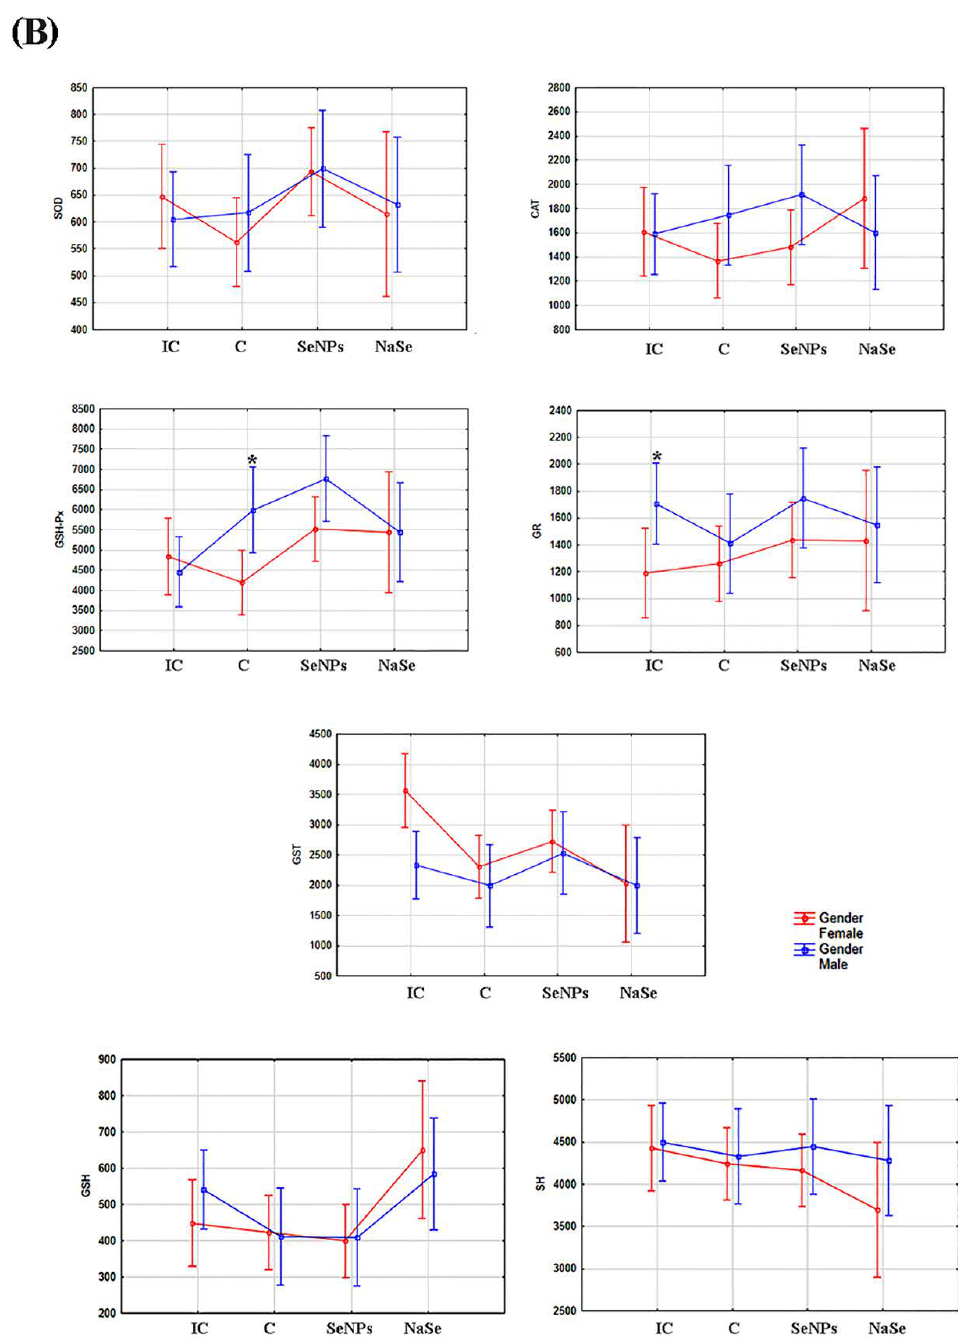
Figure 5. The activities of SOD (U/g wet mass), CAT (U/g wet mass), GSH-Px (U/g wet mass), GR (U/min/g wet mass) and GST (U/g wet mass), and the concentrations of total GSH ( µ mol/ g tissue) and SH (nmol/g tissue) in the placenta. ( A )—Differences between treated groups. ( B )—Differences between fetuses of a different gender. Intact controls-IC; controls-C; Se nanoparticles-treated animals- SeNP; sodium selenite-treated animals-NaSe. The data are expressed as the mean ± S.D. One-way ANOVA post hoc Fisher’s LSD test was used. * Significantly different when p <